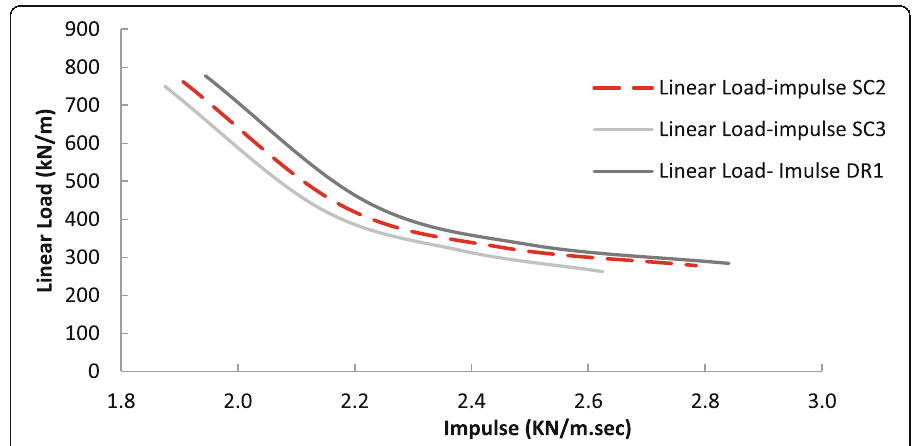
Fig. 28 Linear load — impulse diagram for connections SC2 and SC3 and